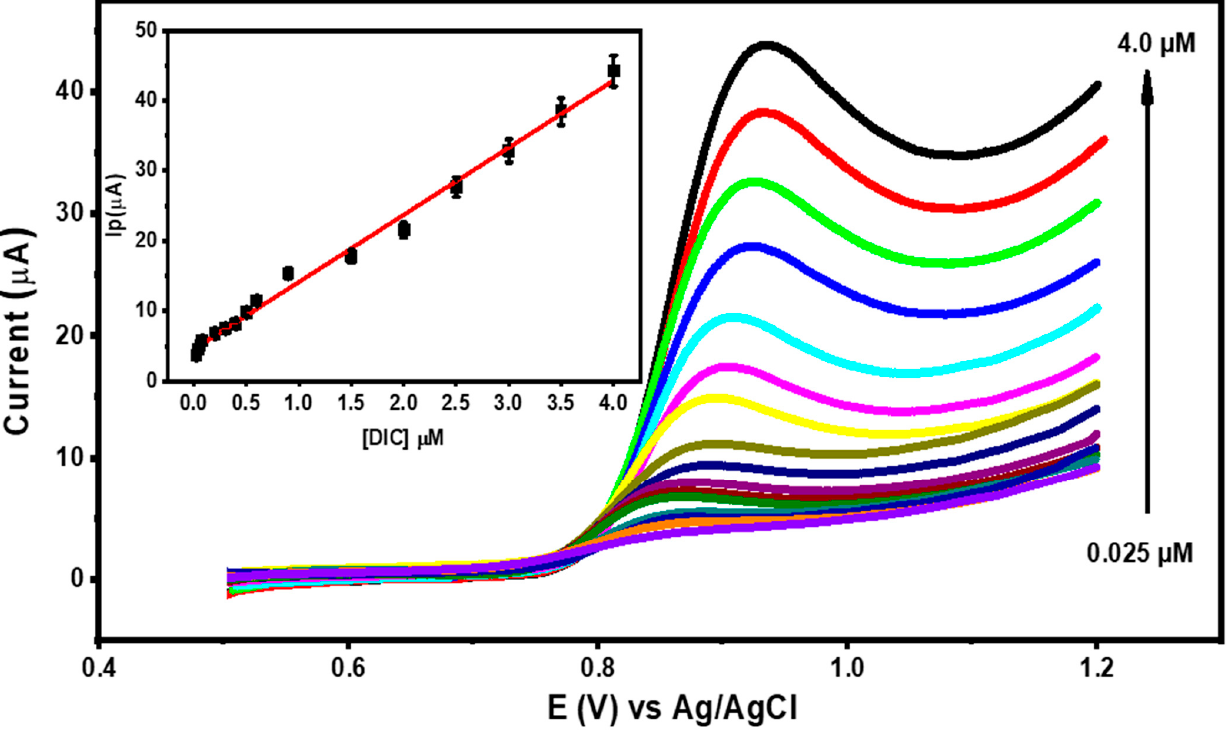
Figure 10. DPVs for different concentrations of DIC in 0.1 M of BR buffer (pH = 3.0) at M-Chs NC/CPE. Insets: The calibration curve of DIC (linear range 0.025 µM to 4.0 µM). Table 1. Comparison of the linearity range and LOD for the determination of OFL and CIP using different electrodes.